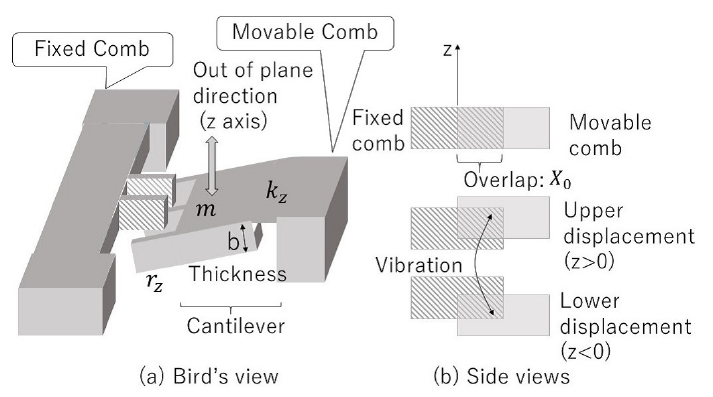
Figure 1. ( a ) A schematic model of the vibration energy harvester. Comb-drive electrodes are formed at a cantilever structure that vibrates in the out-of-plane direction; ( b ) A side-view image of relative positions between the fixed and movable comb-drive electrodes.